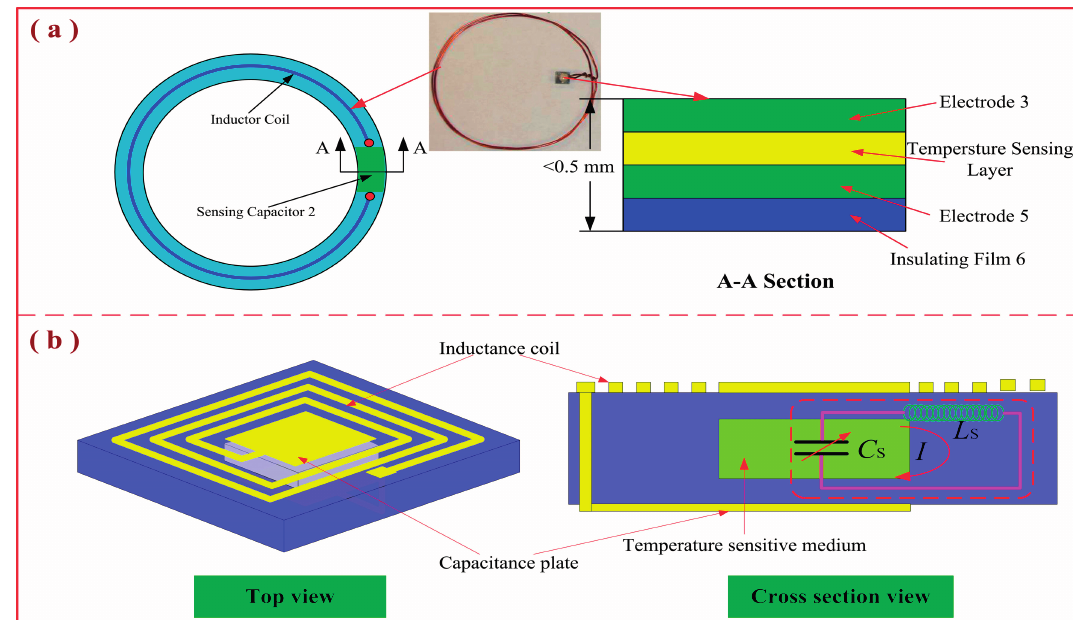
Figure 4. Wireless passive LC temperature